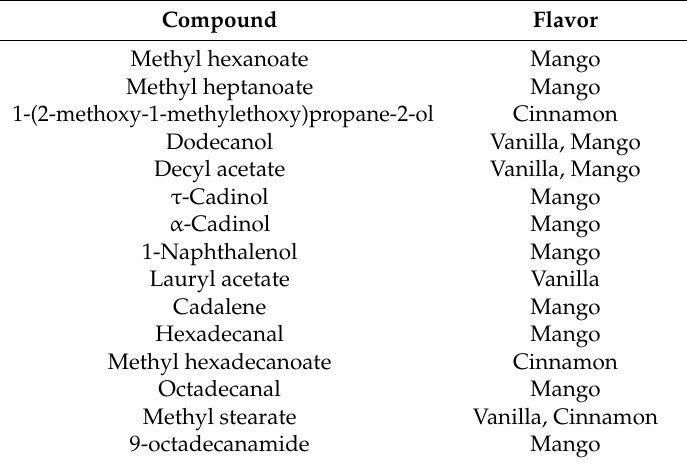
Table 9. Compounds observed only in the filter